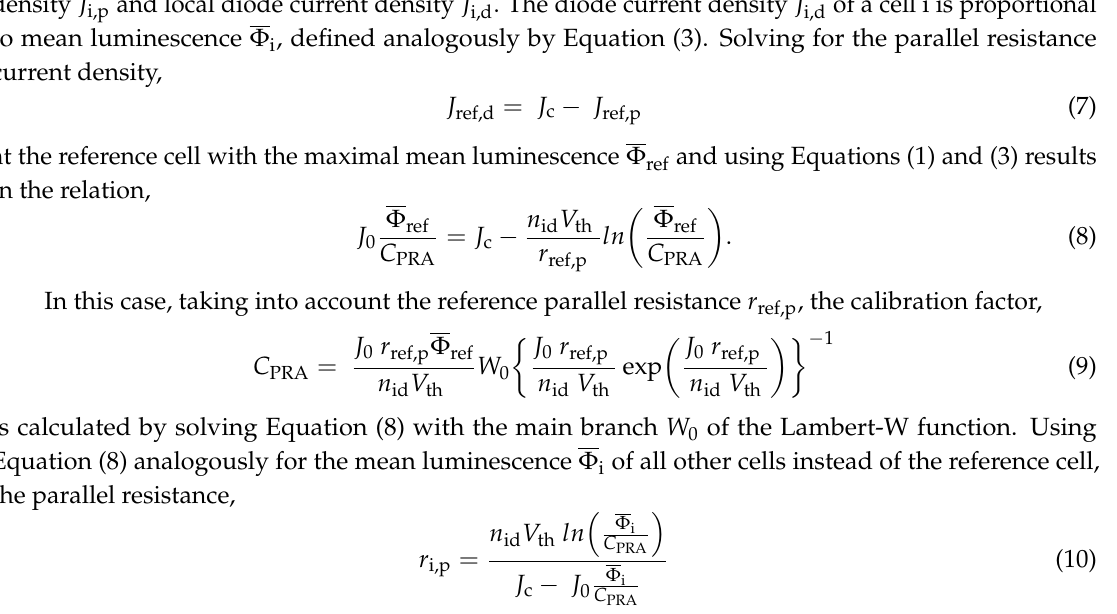
in the low current i